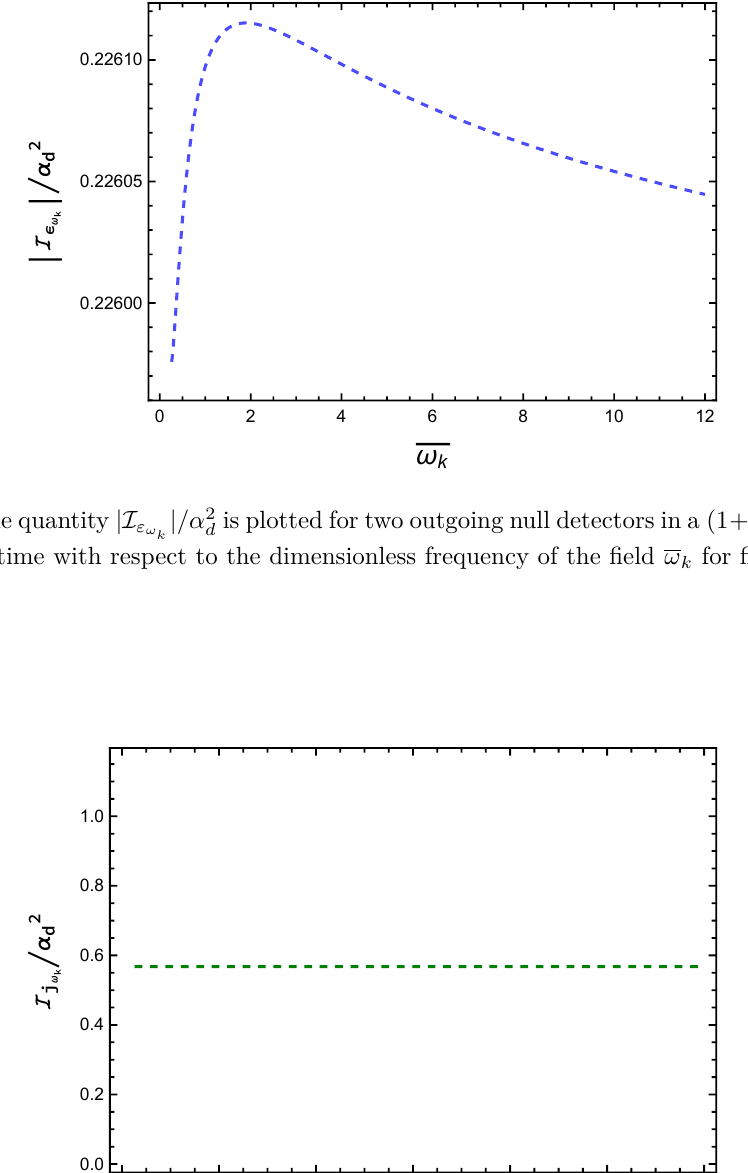
, signifying the individual detector transition probability, is Figure 11 . The quantity I j /α 2 d ωk plotted as a function of the dimensionless frequency of the field ω for a detector in an outgoing k null path in a (1 + 1) dimensional de Sitter spacetime. The dimensionless transition energy of the detector is fixed at ∆ E = 0 . 5 . From this figure, one can notice that the individual detector transition probability, in this case, is independent of the frequency of the field ω . From (6.23) one k should note that they are also independent of d/α d